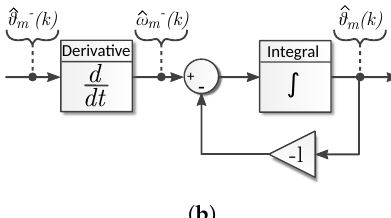
Figure 7. Simplified block diagram of the output vs. measurement loop estimation loop